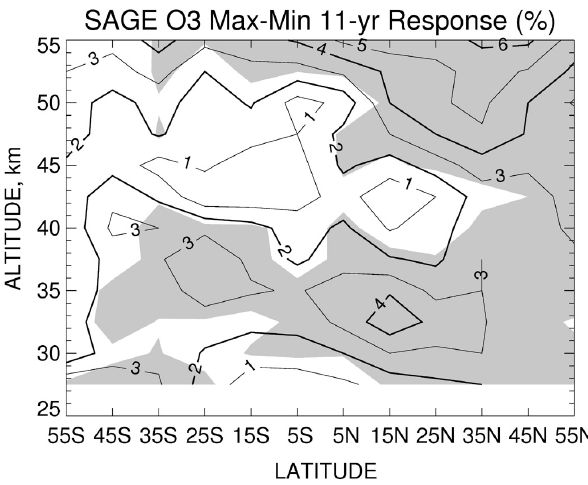
Fig. 10. As in Fig. 7, but the phases are from the SAGE II data from September 1992 through August 2005.